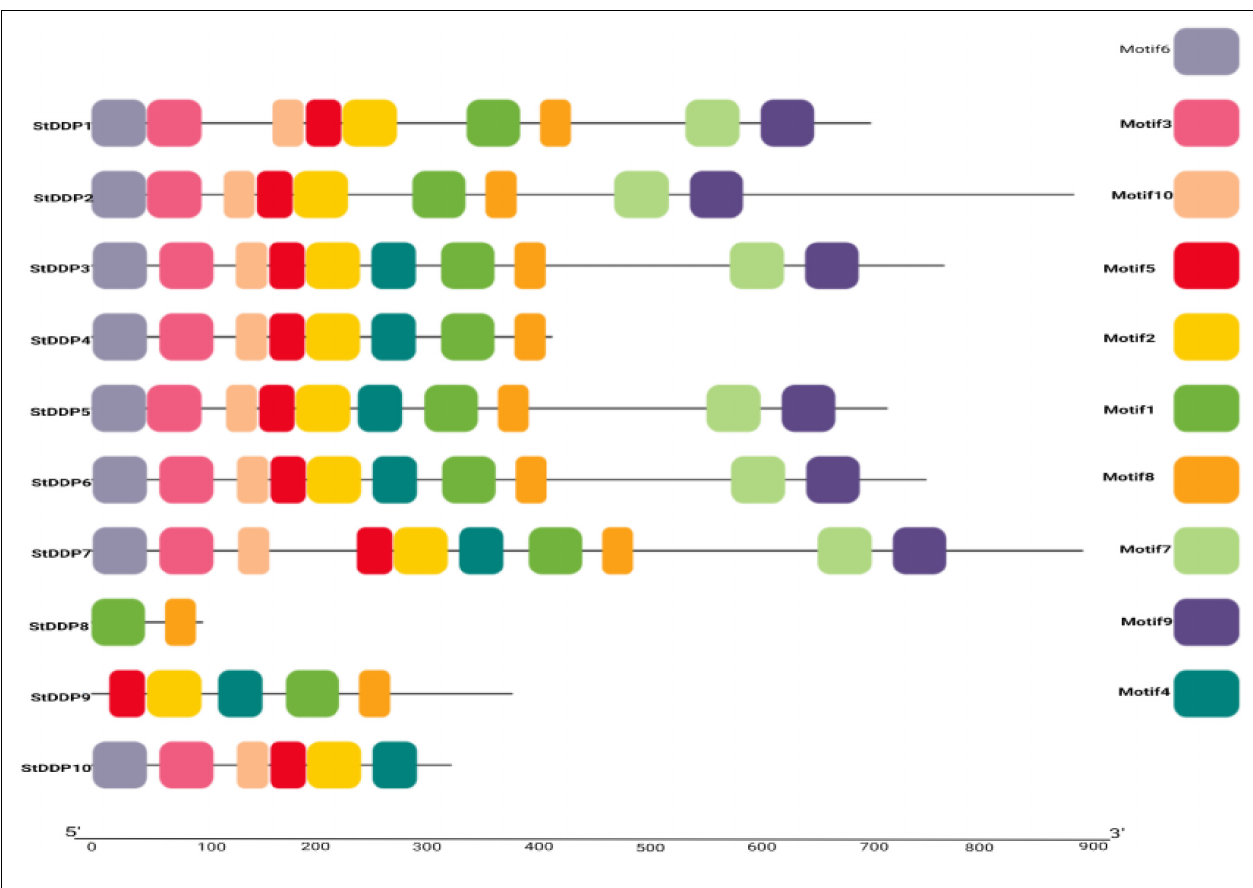
FIGURE 3 | De novo MEME motifs’ distributions in the StDDP